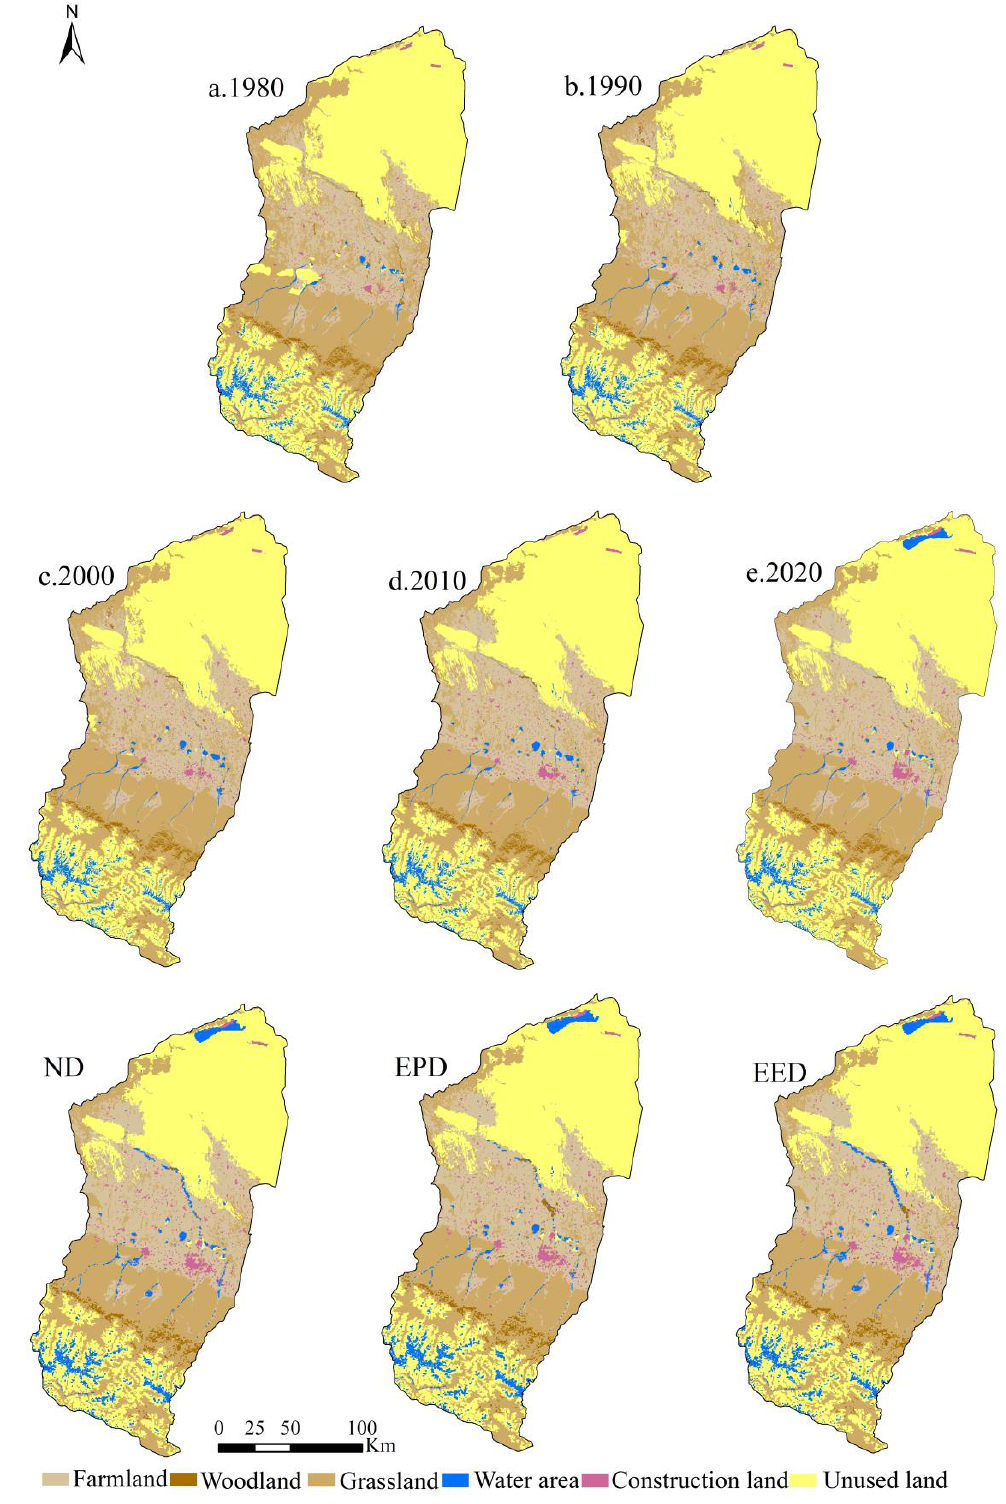
Figure 4. Spatial distribution characteristics of LULC in the Manas River Basin.